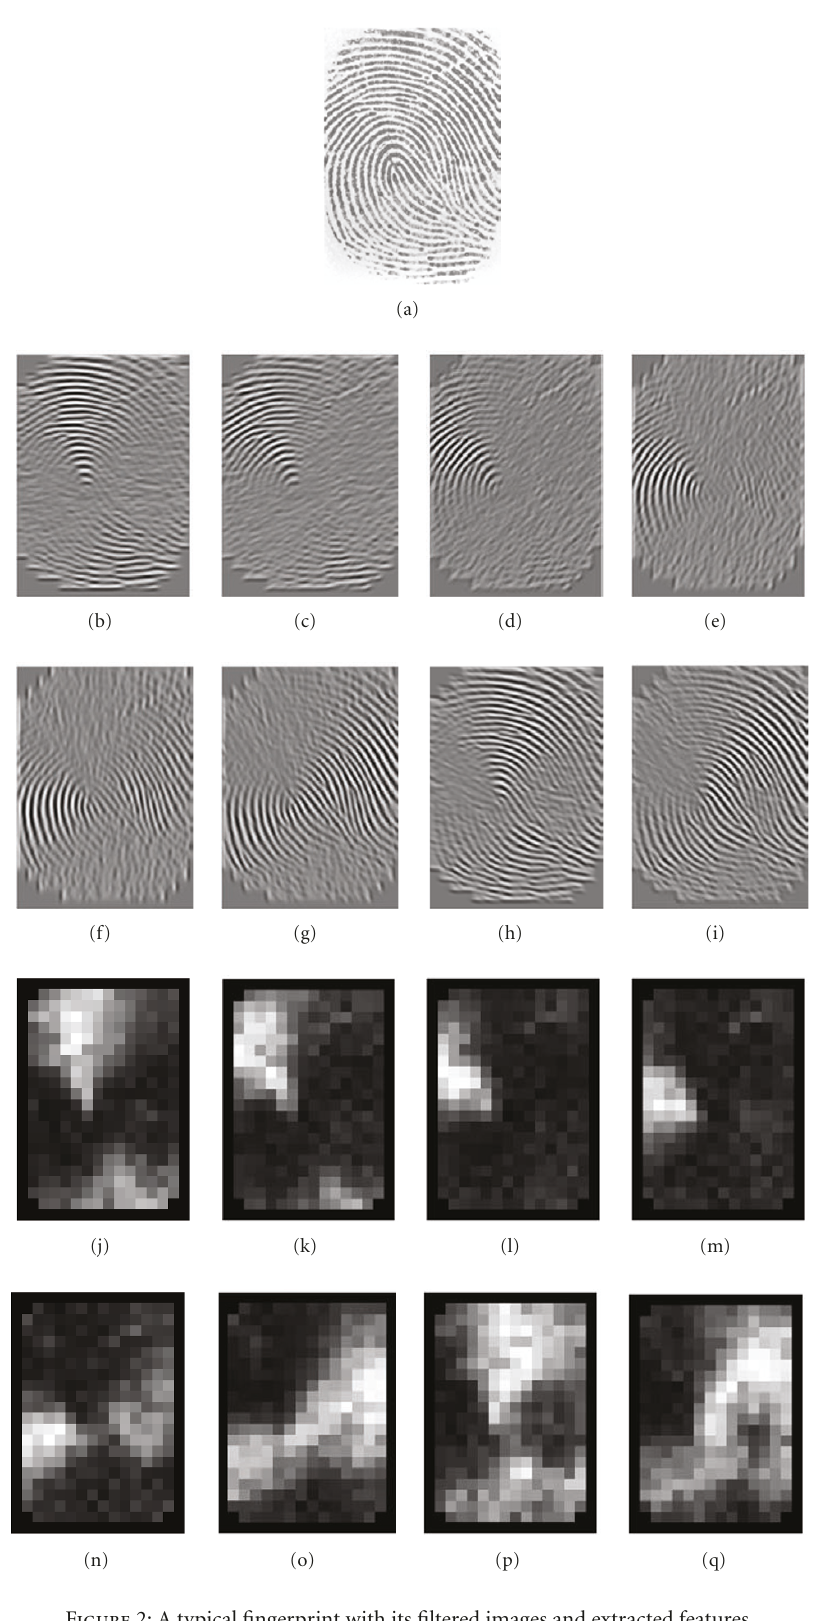
Figure 2: A typical fingerprint with its filtered images and extracted